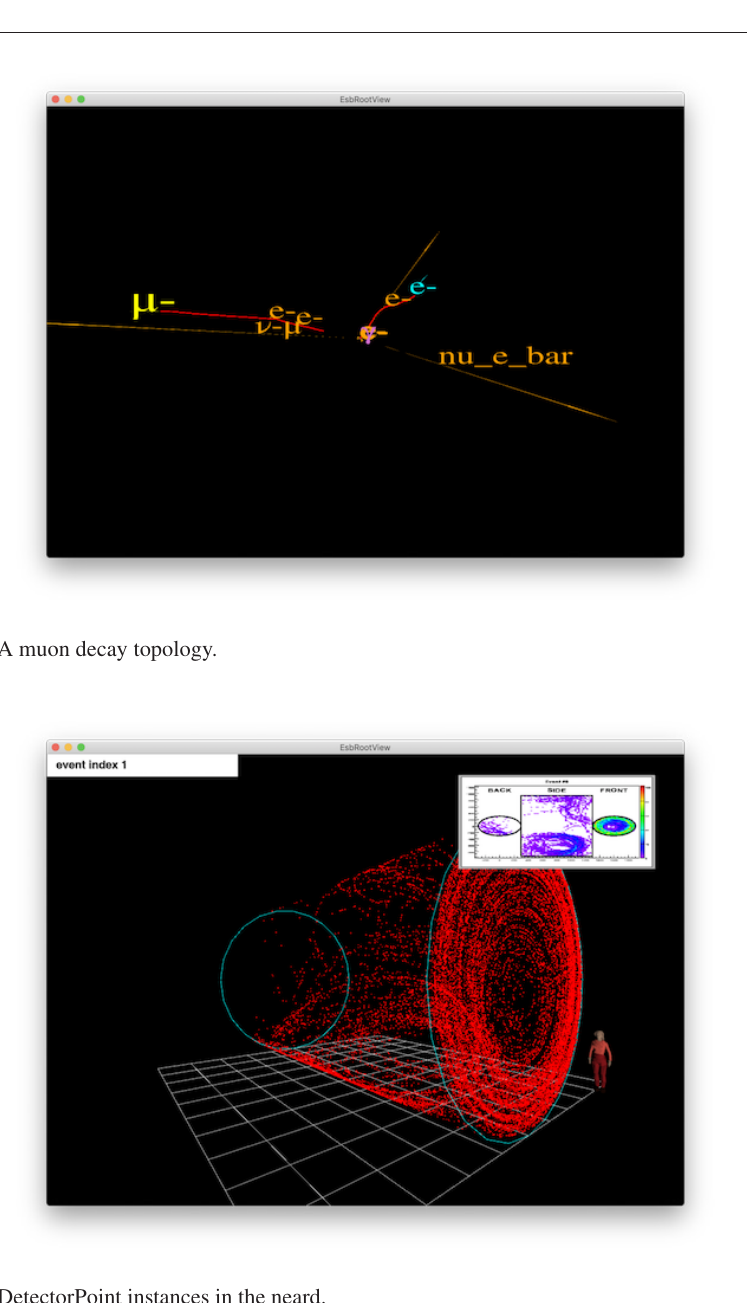
Figure 2. DetectorPoint instances in the